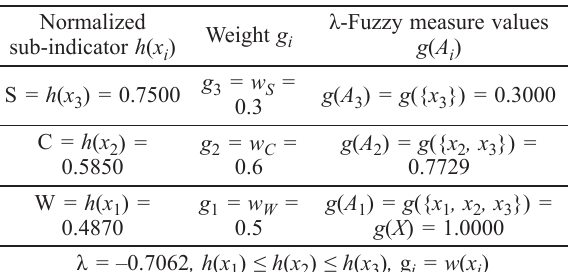
Table 2. h ( x i ), g i and λ-fuzzy measure values for project 4 example. Normalized sub-indicator h ( x i )